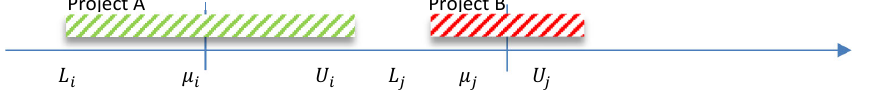
Fig. 5. Possible Condition 1- Different Means and Different Domain